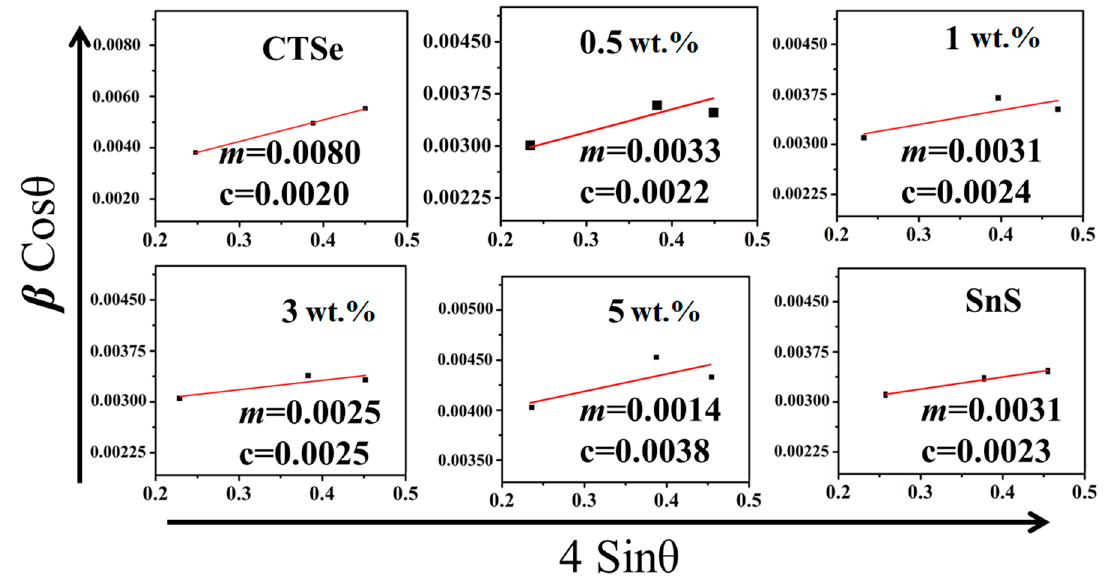
Figure 3. Results of Williamson and Hall (W-H) method. Plot of β hkl cos θ vs. 4 sin θ of the spark plasma sintered Cu 2 SnSe 3 , SnS, and Cu 2 SnSe 3 -SnS composites.